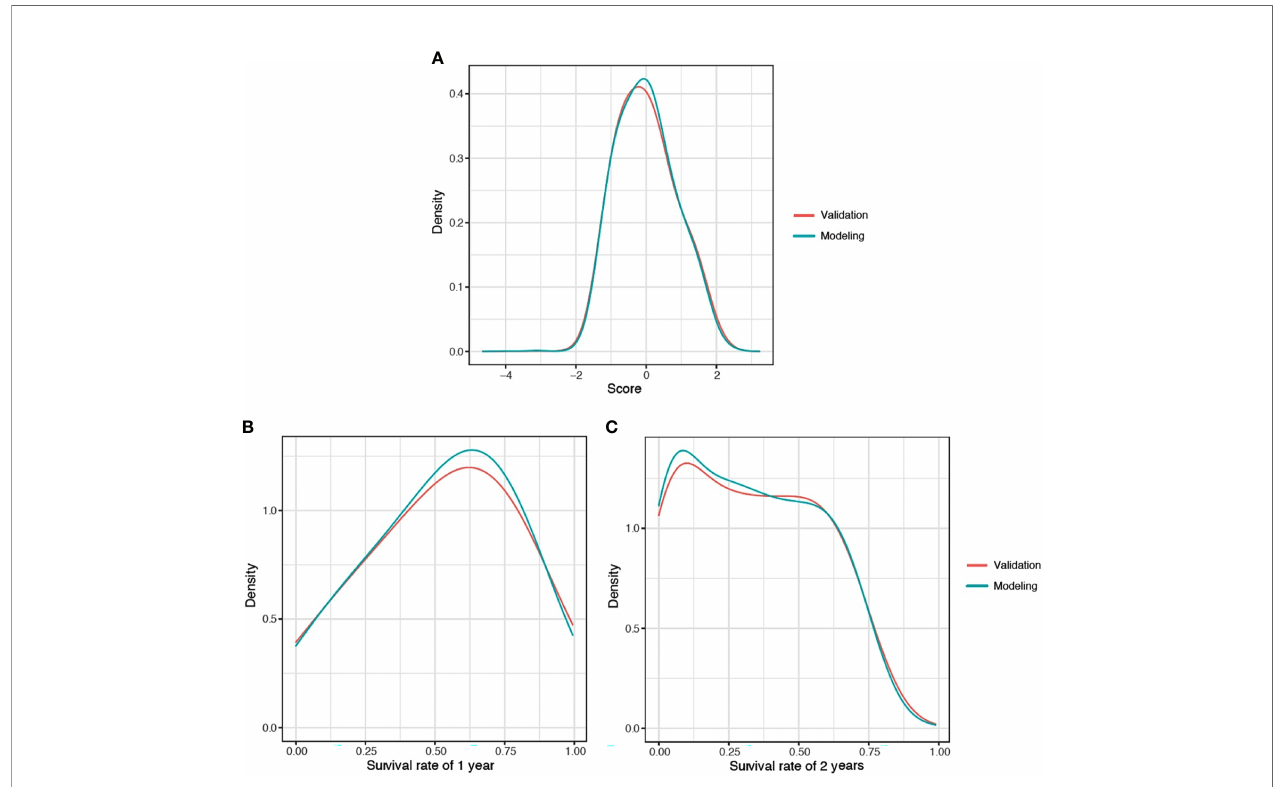
FIGURE 4 | Distribution plot for score (A) , 1-year (B) , and 2-year (C) survival rate of CLM patients. CLM, colon cancer liver